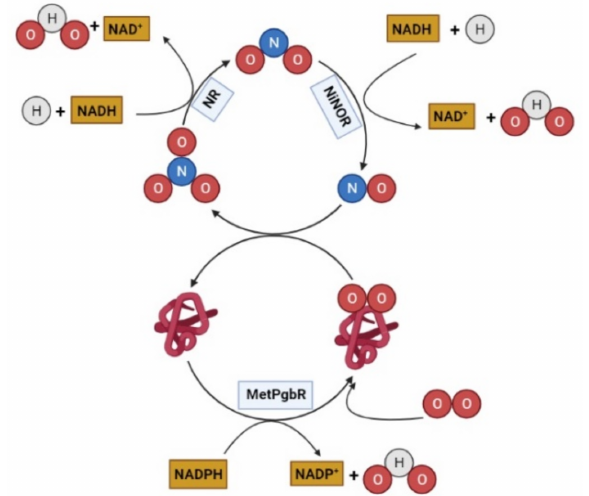
Figure 2. Pgb1-NO cycle (Adapted from Gupta et al. [66], permission obtained); Diagram generated using BioRender.com; NO, nitric oxide; NR, nitrate reductase; NiNOR, NO reductase; MetPgbR, metphytoglobin